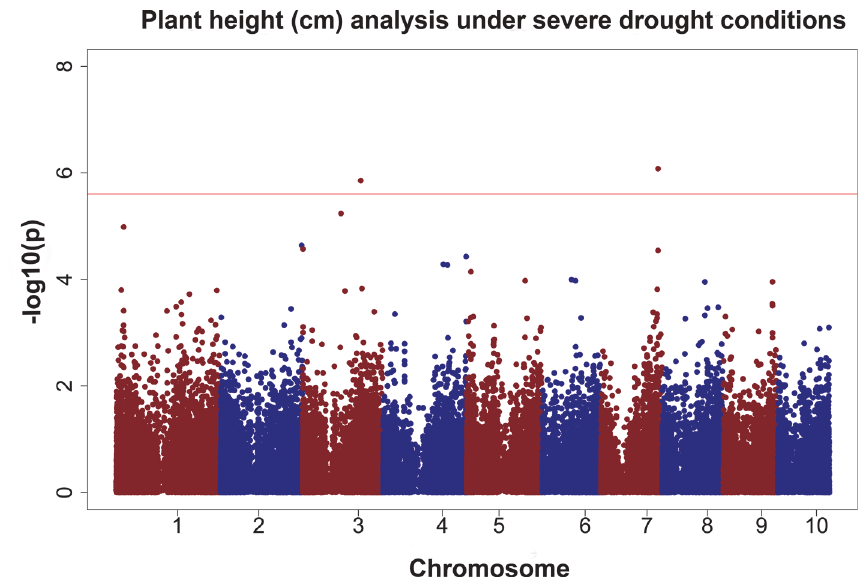
Fig 4. GWAS results for plant height (cm). The phenotypic observation was the BLUPs for the CS11-DTYL trial. The red line represents the threshold value after correcting for multiple testing using the M eff or FDR.